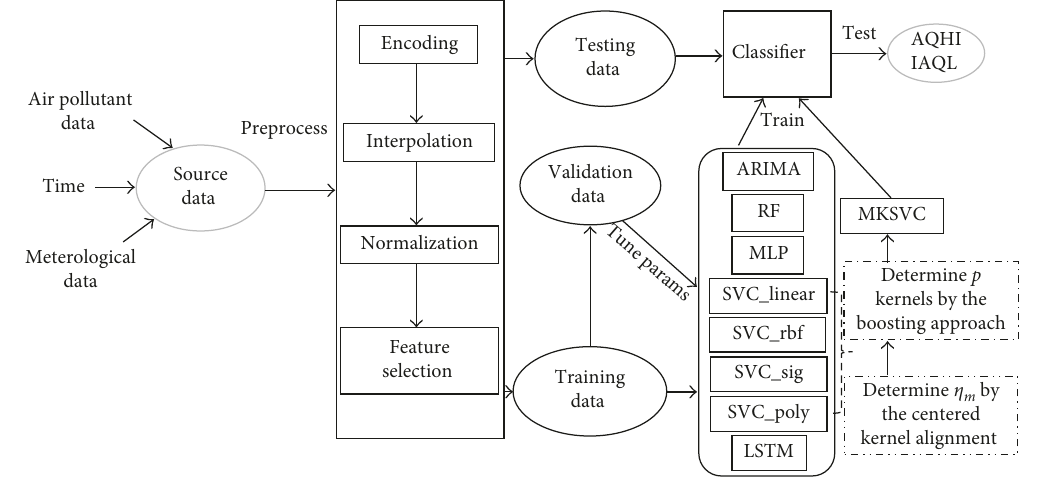
Figure 7: Experiment flow.